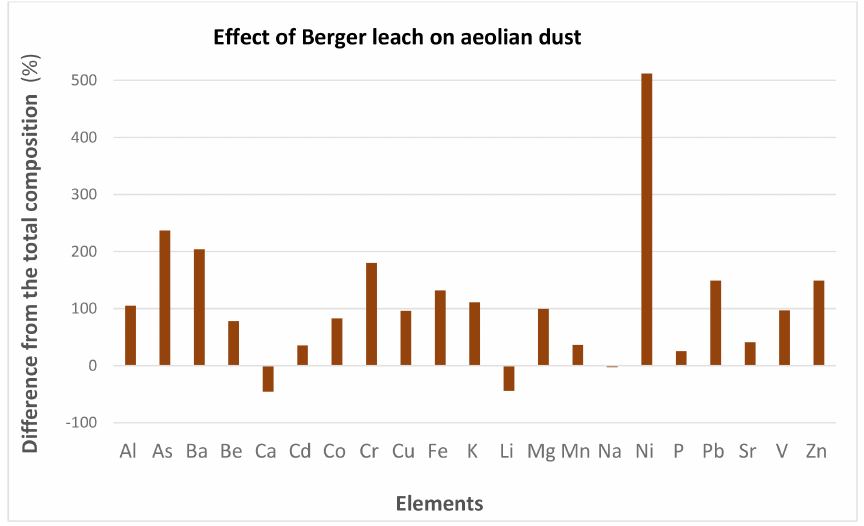
Figure 3. The difference between unleached and leached Qatari dust samples expressed as the percent difference from the unleached com- position. Molybdenum (Mo) is not shown because its difference ( + 3350%) was off scale.